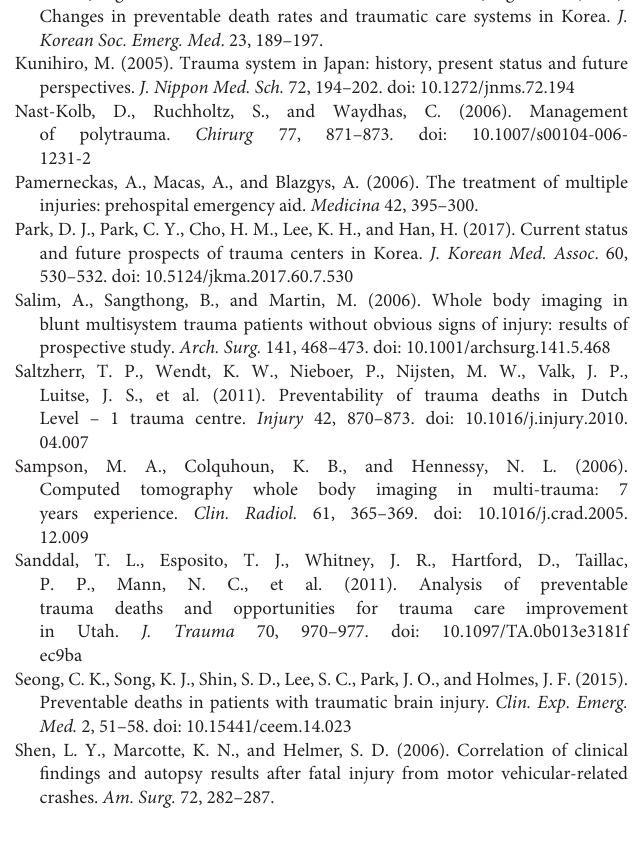
algorithm for the initial management of polytrauma